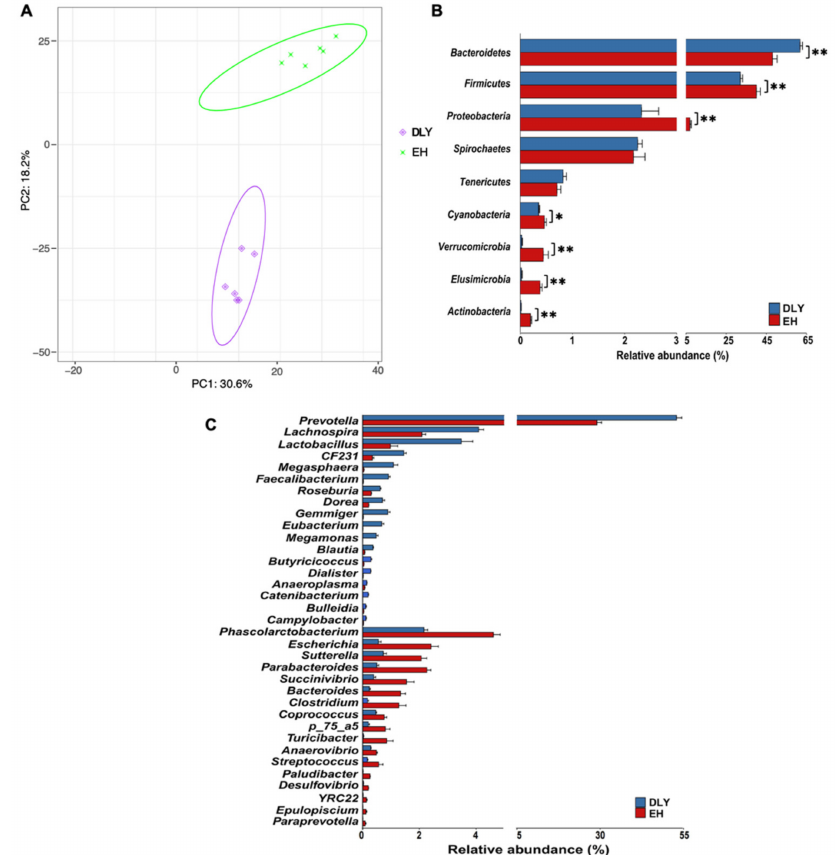
Figure 3. Profiles of the gut microbiota composition of DLY and EH pigs. ( A ) Profiles of the gut microbiota composition based on genera and visualized by PCA. ( B ) Gut microbiota composition at Metabolites 2022 , 12 , x FOR PEER REVIEW the phylum level. ( C ) Gut microbiota genera showing differential abundance between DLY and EH pigs. Data were expressed as means ± SEM; * p < 0.05, ** p < 0.01.